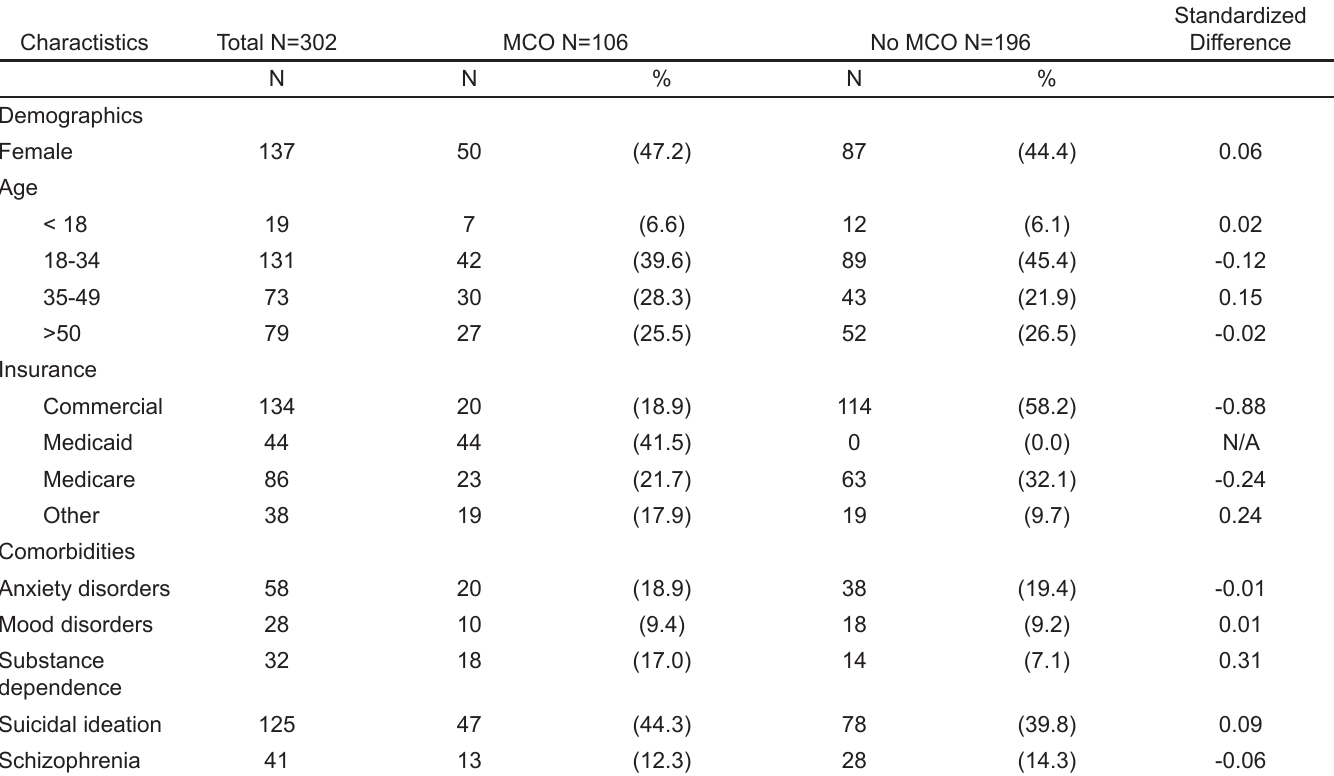
Table 1. Comparison of demographics between cohorts receiving and not receiving mobile crisis outreach consultation.